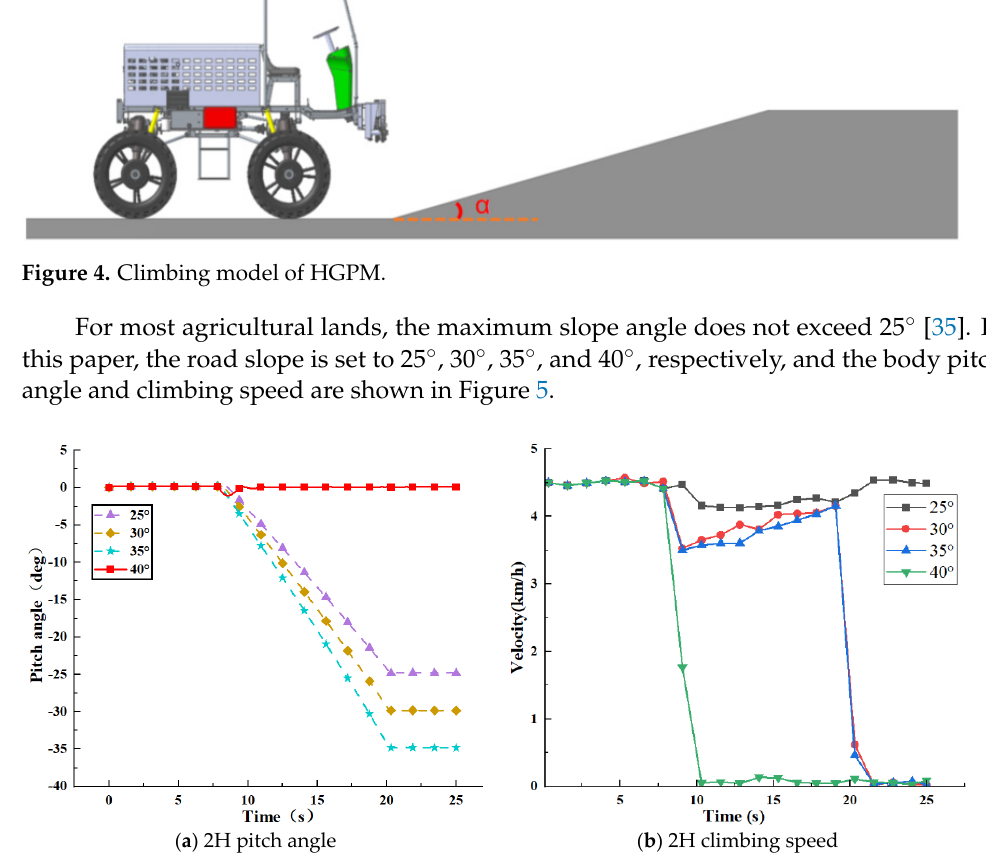
Figure 5. Results of the 2H climbing test.